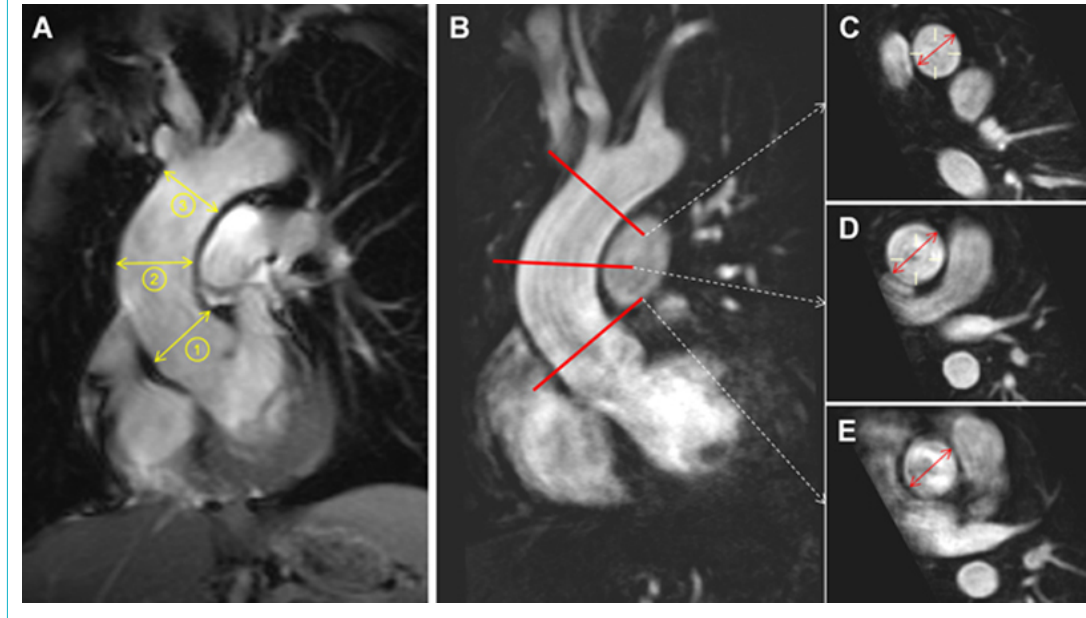
Figure 1: Measurement of the aortic diameters. A. With datasets where 3-D MR-angiography was not available, the luminal diameters, at end- diastole, were directly measured on a non-cine SSFP acquisition of the ascending aorta in the coronal plane at three different levels: (1) sino- tubular junction, (2) proximal ascending and (3) distal ascending aorta. B. In all cases where MR-angiography was available the maximal di- ameters were measured on the individual aortic cross-section planes reconstructed at the level of the distal ascending aorta (C), proximal ascending aorta (D) and sino-tubular junction